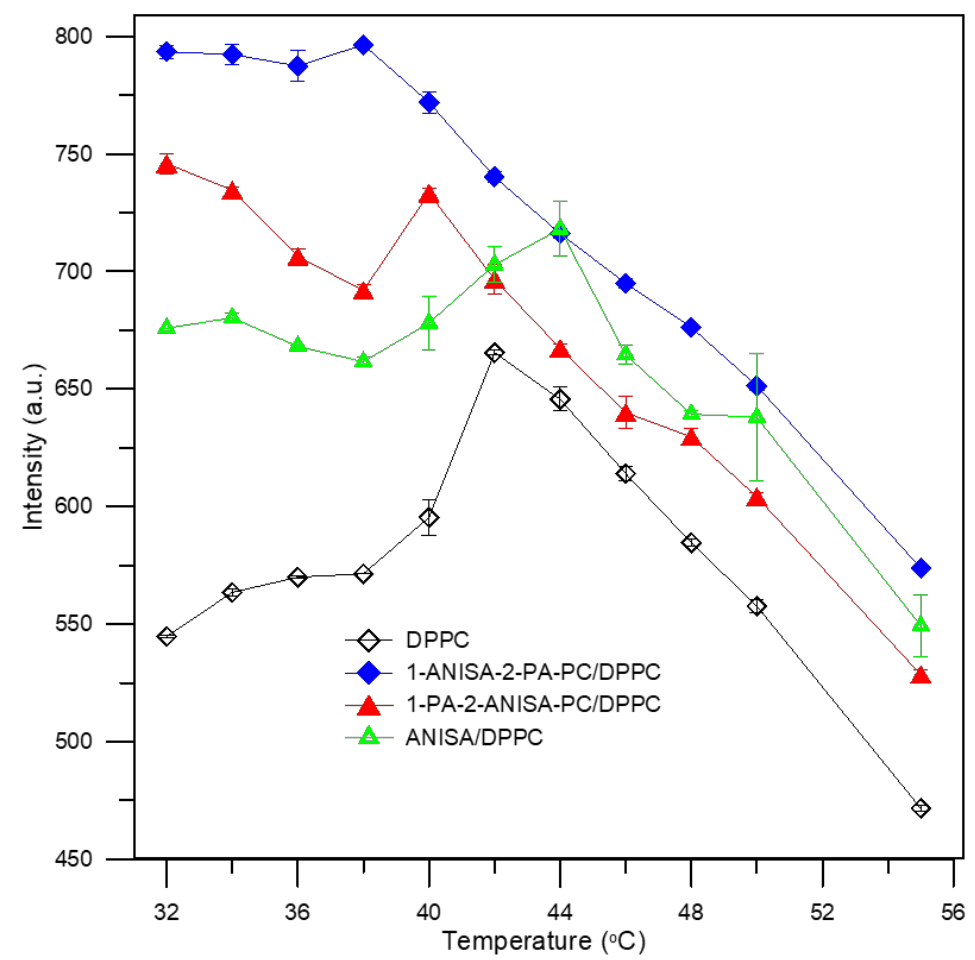
Figure 3. Fluorescence intensity of MC540 probe measured at 585 nm for liposomes formed from DPPC (control) and new forms of liposomes (1-ANISA-2-PA-PC/DPPC, 1-PA-2-ANISA-PC/DPPC DPPC (control) and new forms of liposomes (1-ANISA-2-PA-PC/DPPC, and ANISA/DPPC) (tested probes) at molar ratio of 1:5, as a function of temperature.